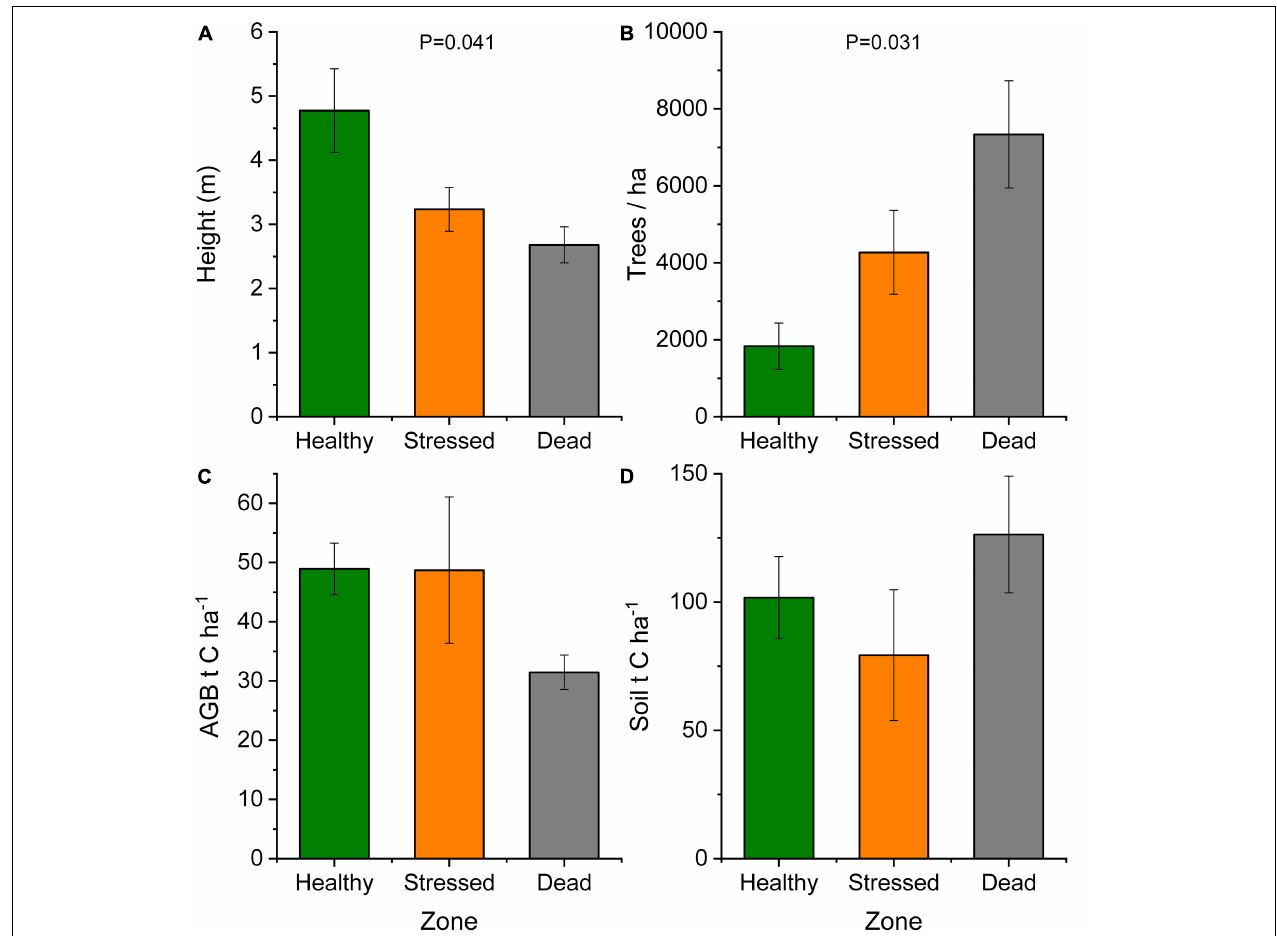
FIGURE 6 | Mangrove forest characteristics at St Kilda, South Australia, showing mean ± standard error for (A) tree height and (B) tree density across mangrove zones. The carbon stock is shown for (C) above-ground biomass (AGB) and (D) soil to 50 cm depth across the mangrove zones. Trees in the “dead” zone constitute necromass and were in decay status